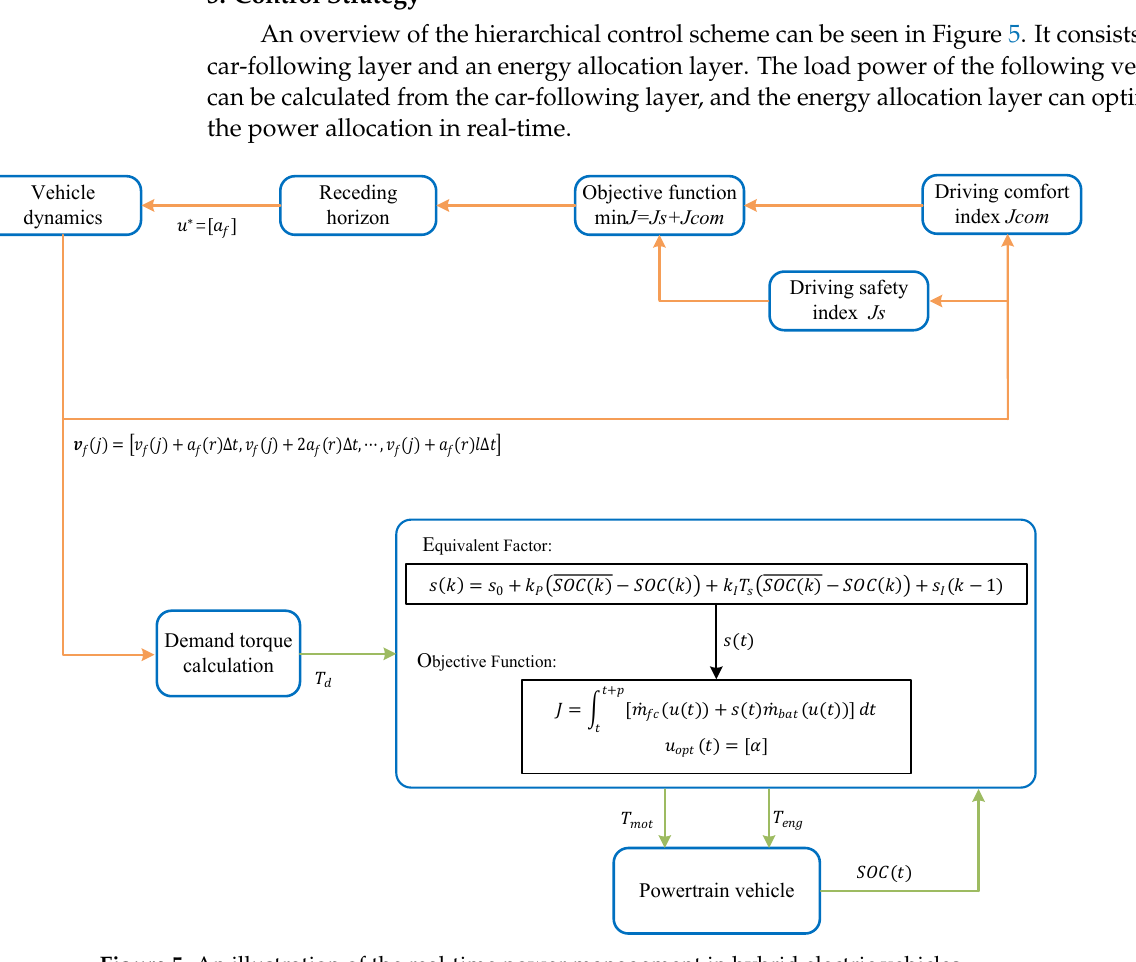
Figure 5. An illustration of the real-time power management in hybrid electric